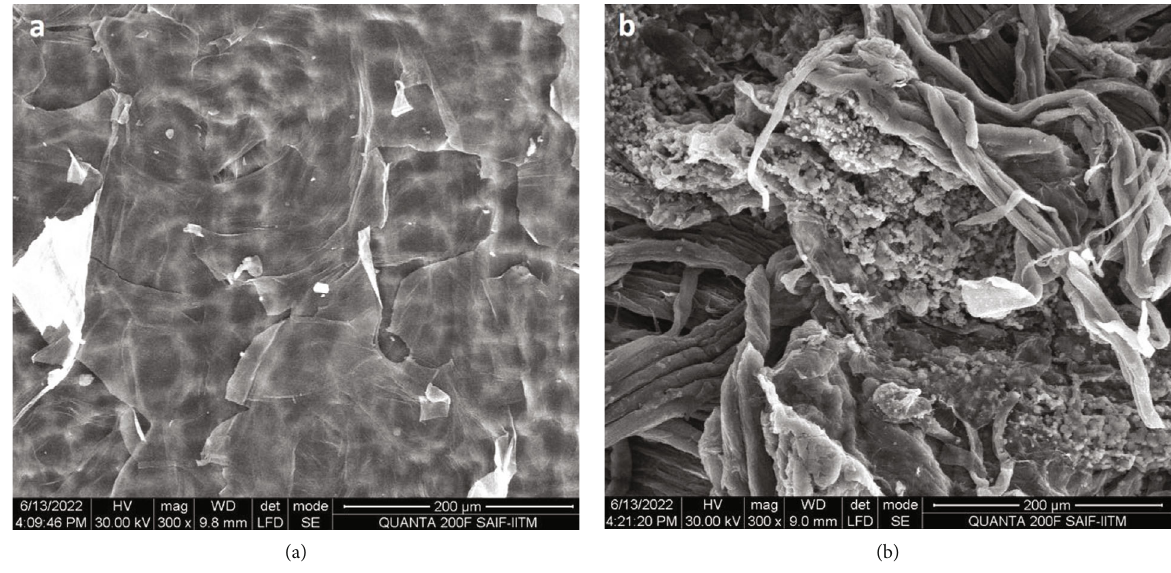
Figure 2: SEM image of (a) unmodi fi ed GP and (b) modi fi ed